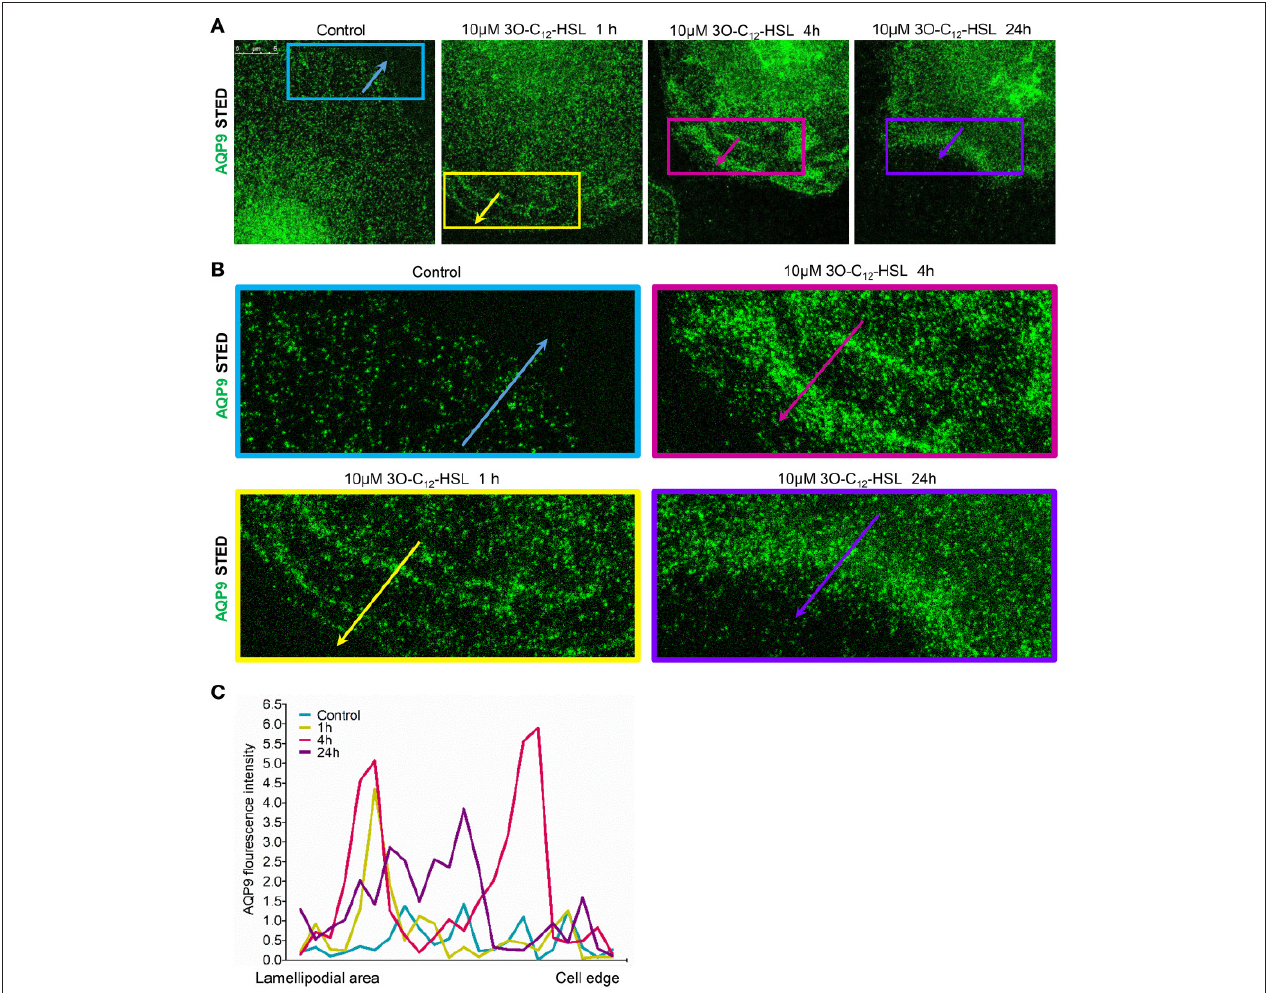
FIGURE 8 | Nanoscale visualization of AQP9 dynamic in lamellipodial area in 3O-C 12 -HSL stimulated macrophages. Macrophages were stimulated with 10 µ M 3O-C 12 -HSL for 1, 4, or 24h, or 0.02% DMSO as a vehicle control (Control), stained for AQP9 (green) and analyzed with STED nanoscopy. (A) Main panels, bar 5 µ m. (B) Inserts, image size is 15.5 × 6.2 µ m. (C) AQP9 fluorescence intensity profiles measured as indicated by colored arrows in (A, B) in the direction from lamellipodial area to the edge of macrophages on the representative